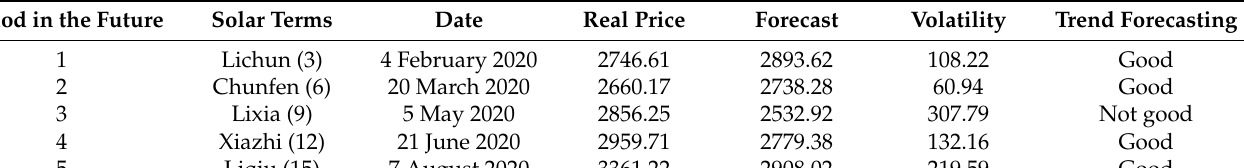
Table 14. Forecasts of the eight-terms group of the Shanghai Index.